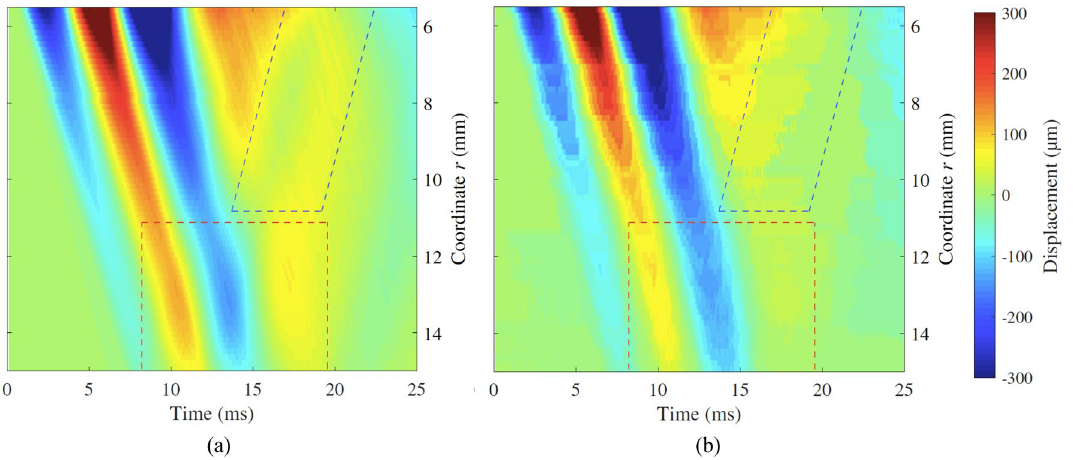
Figure 12. Time-space representation of the wave propagation for the illustrative case, plane A, i.e. with an inclusion. The colour maps represent the particle displacement u θ for ( a ) the model simulation and ( b ) the HSC test. The top side of the figures ( r = 5.5 mm) coincides with the edge of the disk emitter, while the bottom side coincides with the front face of the stiff inclusion ( r = 15 mm). The perturbation due to the interaction between the incident wave and its reflection against the stiff inclusion is observable within the regions contoured by dashed red line. The reflection continued propagating back to the emitter location and is noticeable within the regions contoured by dashed blue